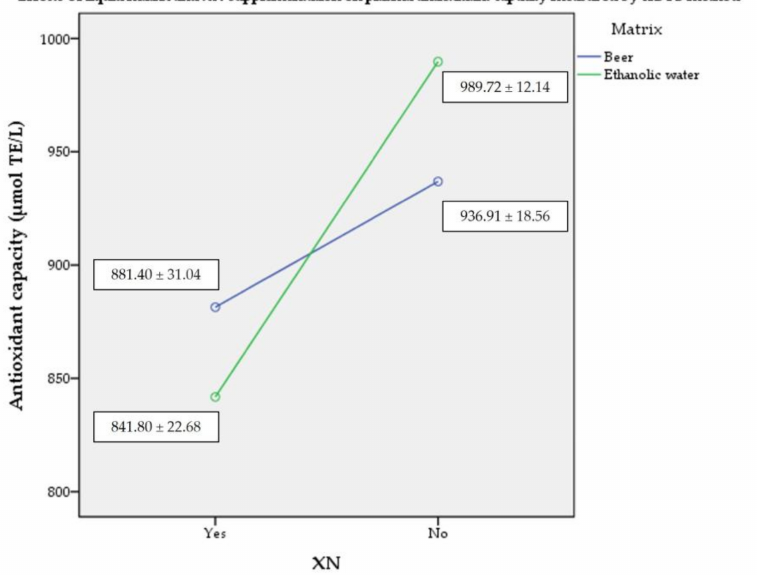
Figure 3. Mean ( ± SD) plasma antioxidant capacity values measured by ABTS method ( n = 4). Abbreviations: TE—Trolox equivalents; ABTS—2,2 (cid:48) -azino-bis(3-ethylbenzothiazoline-6-sulfonic acid; XN—xanthohumol; SD—standard